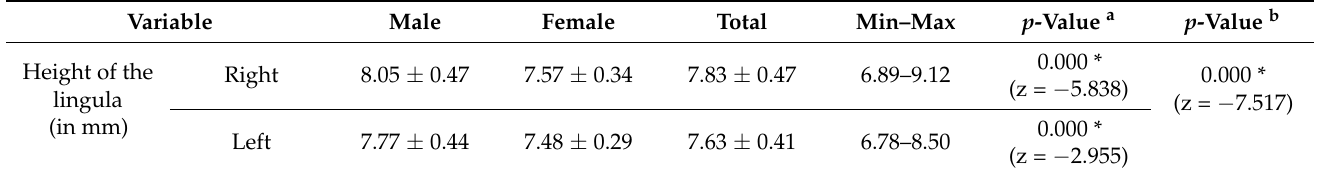
Table 3. Height of the mandibular lingula ( n = 250 sides).